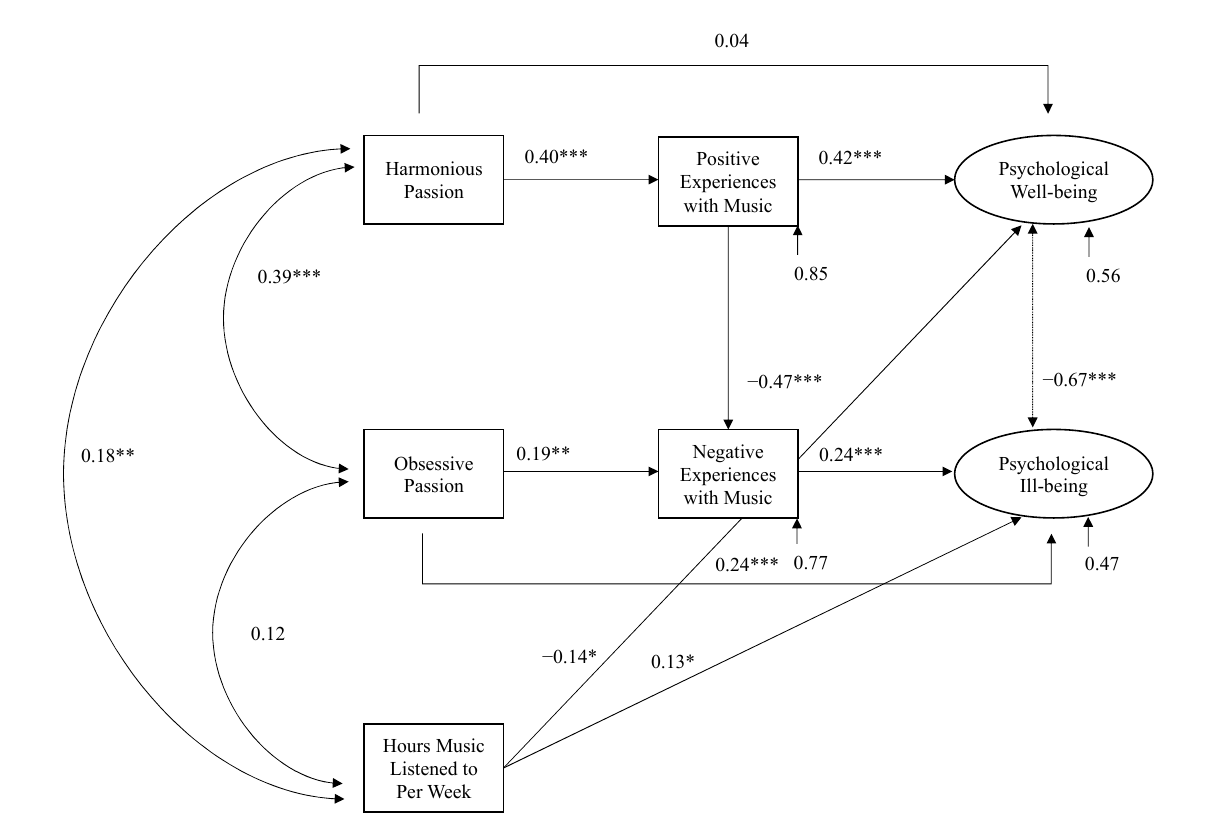
Figure 1. The role of the two types of passion and affective experiences with music on ratings of psychological well-being and ill-being, controlling for hours of music consumed weekly. Numbers in the figure refer to standardised correlation coefficients. * p < 0.05; ** p < 0.01; *** p < 0.001.